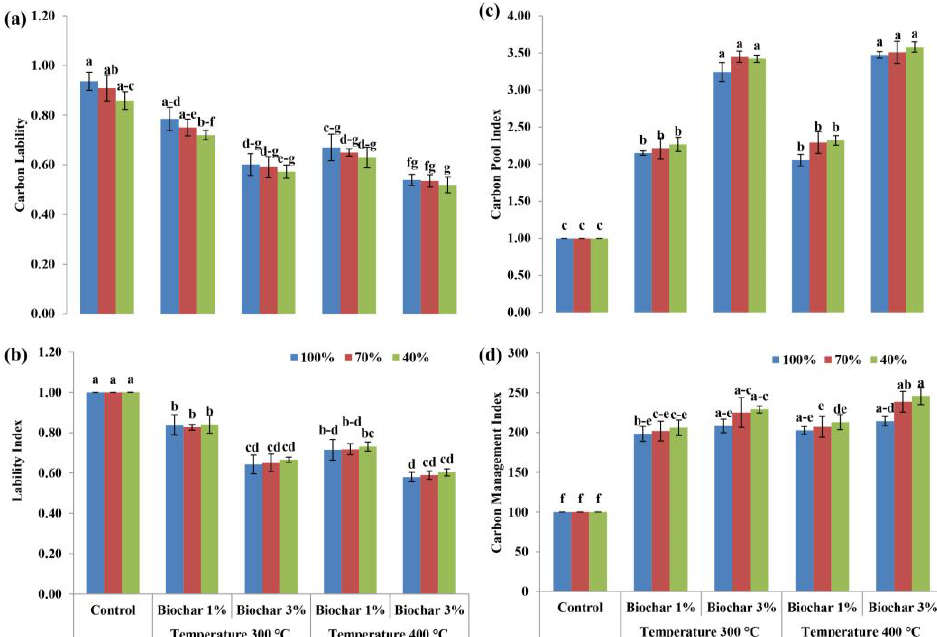
Figure 3. The effect of biochar on ( a ) carbon lability, ( b ) lability index, ( c ) carbon pool index, and ( d ) carbon management index under drought stress. Data with different letters are considered significantly different ( p ≤ 0.05).